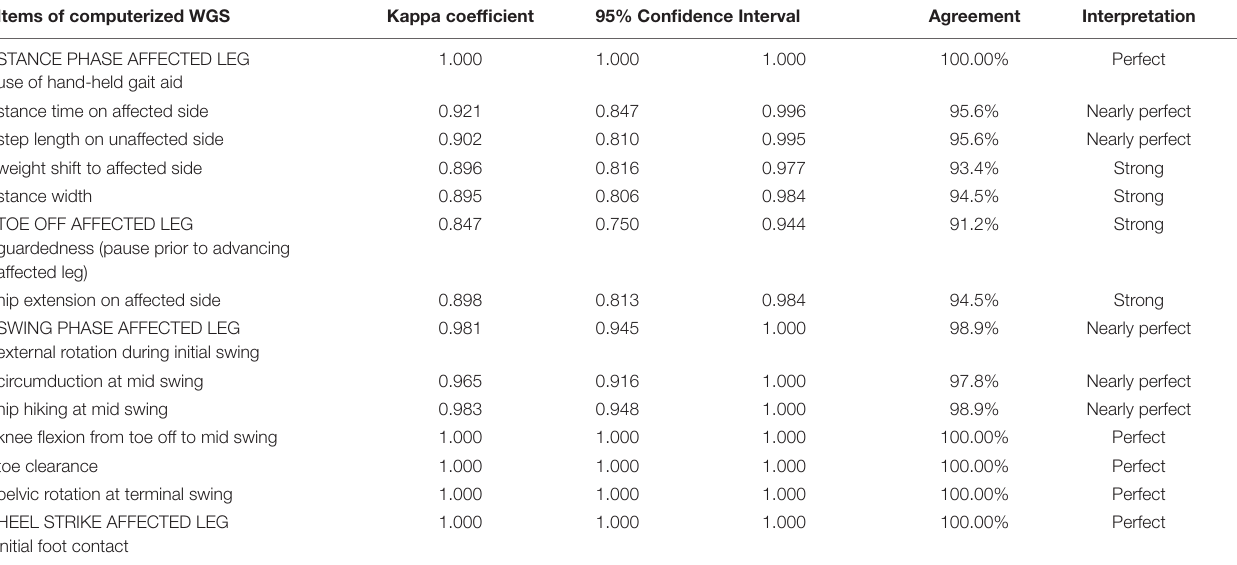
TABLE 4 | Comparison of two measurements performed by the same examiner (intrarater reliability), for all three examiners. Items of computerized WGS